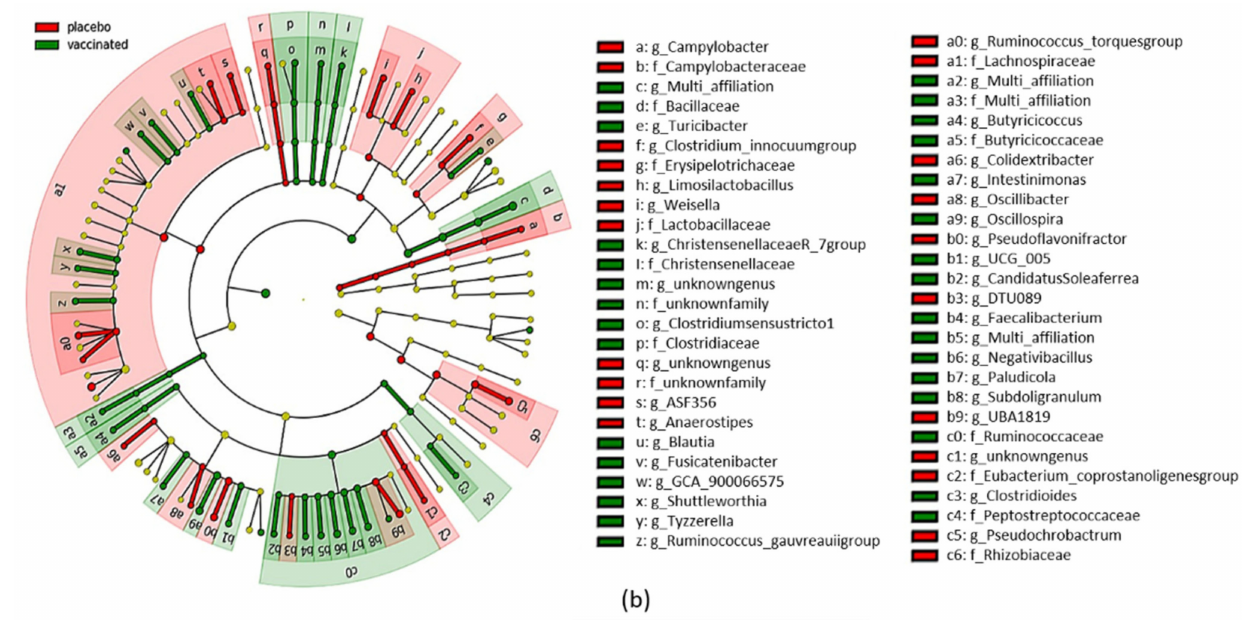
Figure 8. Differential abundances for members of the caecal microbial communities from the vacci- nated and placebo groups on D40, identified by linear discrimination analysis coupled with effect size (LefSE). ( a ) Histogram of the LDA scores computed for taxa with significantly different relative abundance in the vaccinated group in green and placebo group in red. Only taxa belonging to family and genera with an LDA threshold value > two are reported. ( b ) Cladogram representing LefSE results of the identified taxa according to their phylogenetic characteristics. The green circles represent those of greater abundance in the vaccinated group, and red circles those in the placebo group. Yellow indicates non-significant differences between the two groups. The diameters of the circles are proportional to the taxon’s abundance. This representation highlights the presence of the differentially abundant taxonomic levels (f_ family, g_genera) as concentric